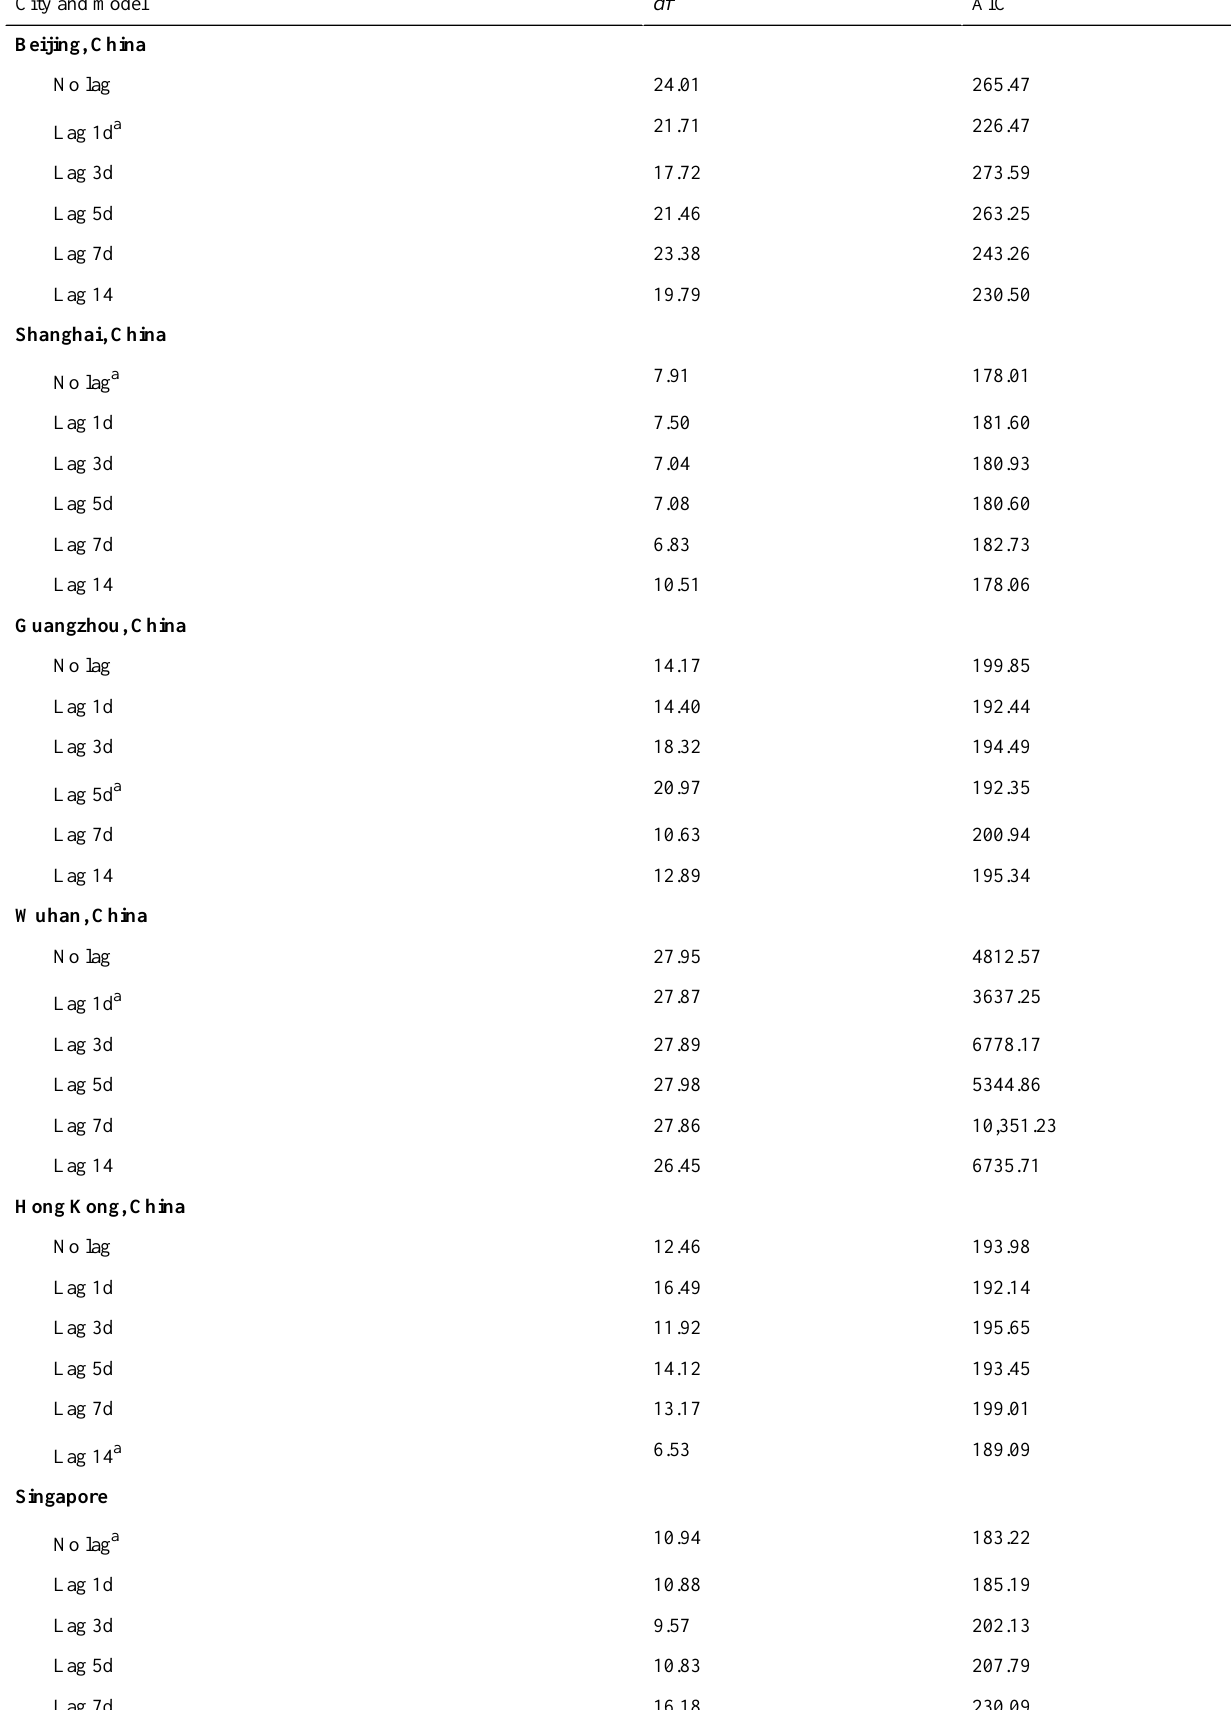
Table 4. The selection of generalized additive modeling by Akaike information criterion